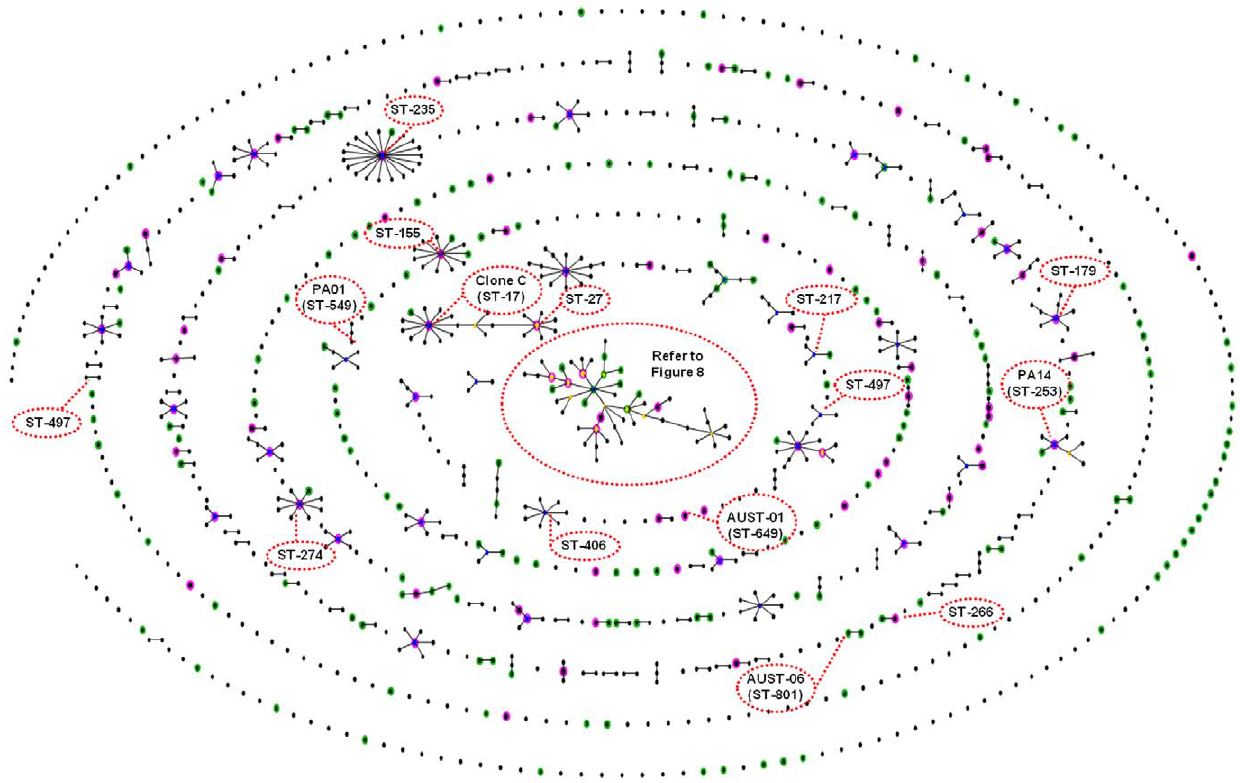
Figure 6. Population snapshot of the 1070 sequence types listed on the Pseudomonasaeruginosa PubMLST database (October 2011). Dots represent sequence types (STs), and lines connect single-locus variants. The snapshot shows all BURST groups (connected STs), singleton STs, ancestral founders (blue STs), and subgroup founders (yellow STs). STs with green halos were detected in the current study only; STs showing pink halos were detected in the current study and elsewhere; STs with no halo were not detected in the current study. Line length and singleton ST placement is arbitrary.